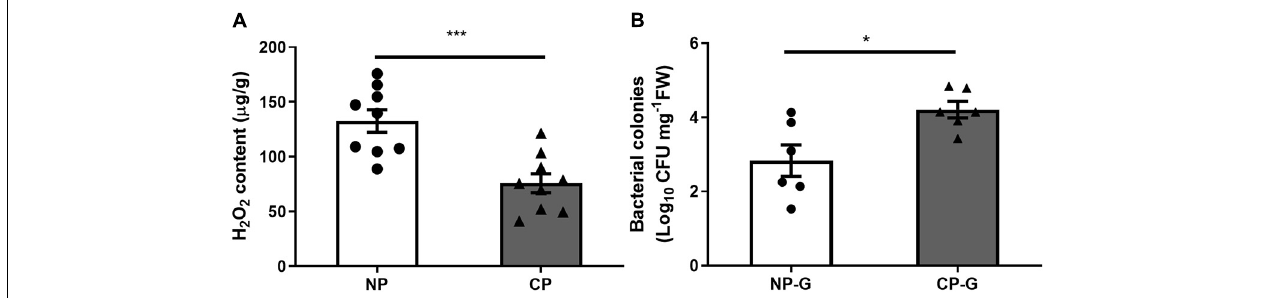
FIGURE 1 | Parasitism inhibited hydrogen peroxide (H 2 O 2 ) levels and increased the bacterial load in the gut of fall armyworm larvae. (A) H 2 O 2 levels in the larval guts were measured using the FOX assay. NP, caterpillars without parasitism; CP, caterpillars parasitized by C . marginiventris . Values are untransformed mean ± SEM ( t = 4.21, p < 0.001, n = 9; unpaired t -test). (B) The number of bacteria in the larval gut was quantified by analyzing colony forming units (CFU). NP-G, gut tissue of caterpillars without parasitism; CP-G, gut tissue of caterpillars parasitized by C . marginiventris . Values are mean ± SEM with log10 transformation ( t = 2.894, p = 0.016, n = 6; unpaired t -test). The asterisk indicates significant differences between treatments (* p < 0.05; *** p < 0.001).